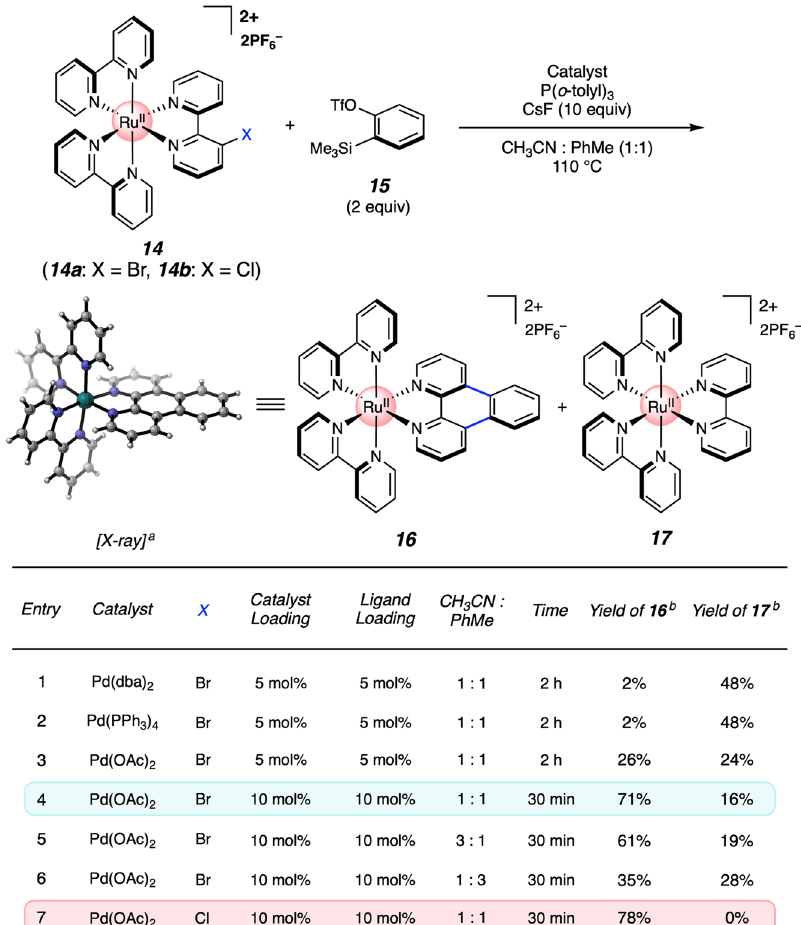
Fig. 3 Optimization studies for Pd-catalyzed annulation of benzyne onto Ru-polypyridyl complex 14. a PF 6 counterions have been removed from the X- ray crystal structure for clarity. b Yields were determined by 1 H NMR analysis, using 1,3,5-trimethoxybenzene as an external standard. OTf, tri fl